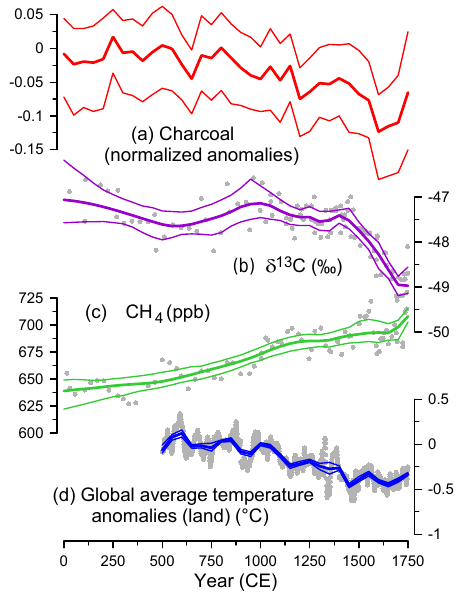
Figure 4. Indices of pre-industrial global biomass burning trends, 0–1750CE: (a) normalized charcoal anomalies, (b) δ 13 C of CH 4 (‰) based on a composite of the data from Ferretti et al. (2005), Mischler et al. (2009), and Sapart et al. (2012), and (c) CH 4 con- centration (ppb) from Etheridge et al. (2010). Panel (d) shows global average temperature anomalies over land ( ◦ C) from Mann et al. (2009). The plots show the 50-year smoothed record for each indicator, with 95% bootstrap confidence intervals; the individual data points for δ 13 C, CH 4 , and land temperature are shown by grey points. There are too many individual charcoal points to be